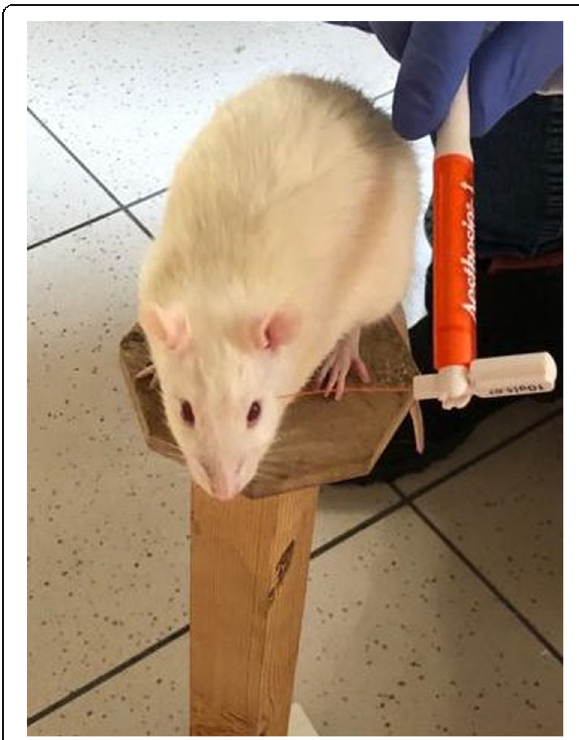
Fig. 3 Representative picture of mechanical allodynia assessment using von Frey filaments in a rat. Application of a filament to the periorbital area is